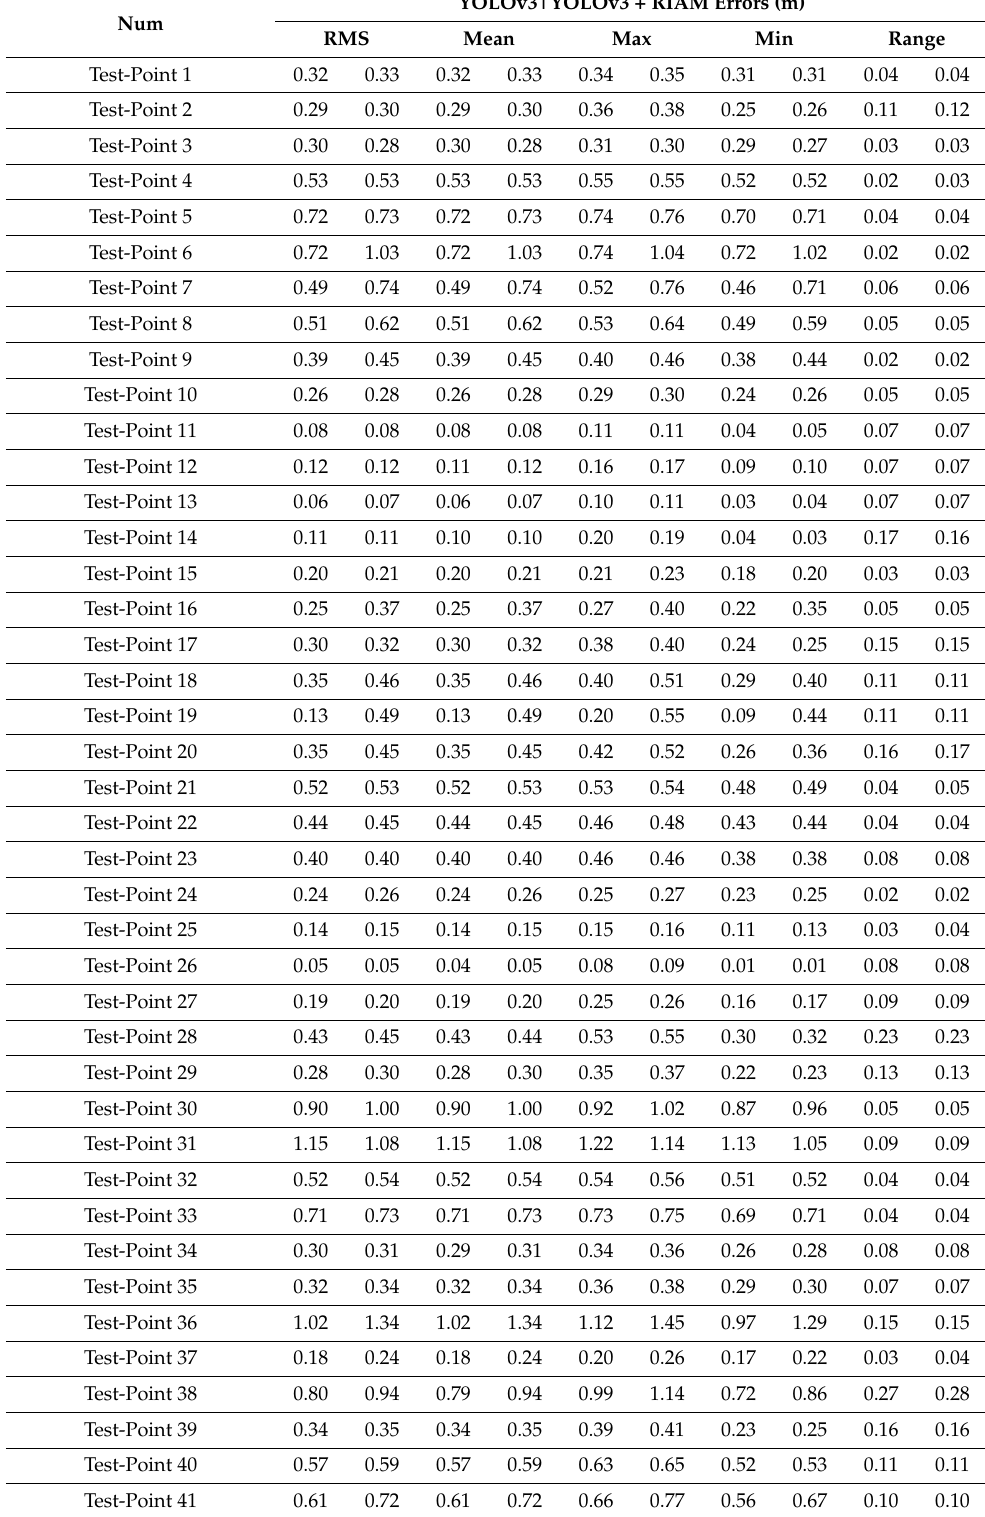
Table 2. Various results for the evaluated 41 test-points.